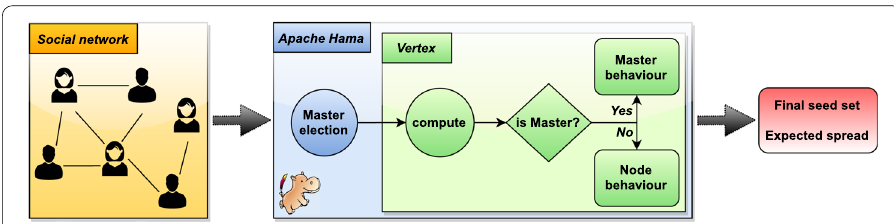
Fig. 6 Architecture of the proposed Hama Vertex-Centric